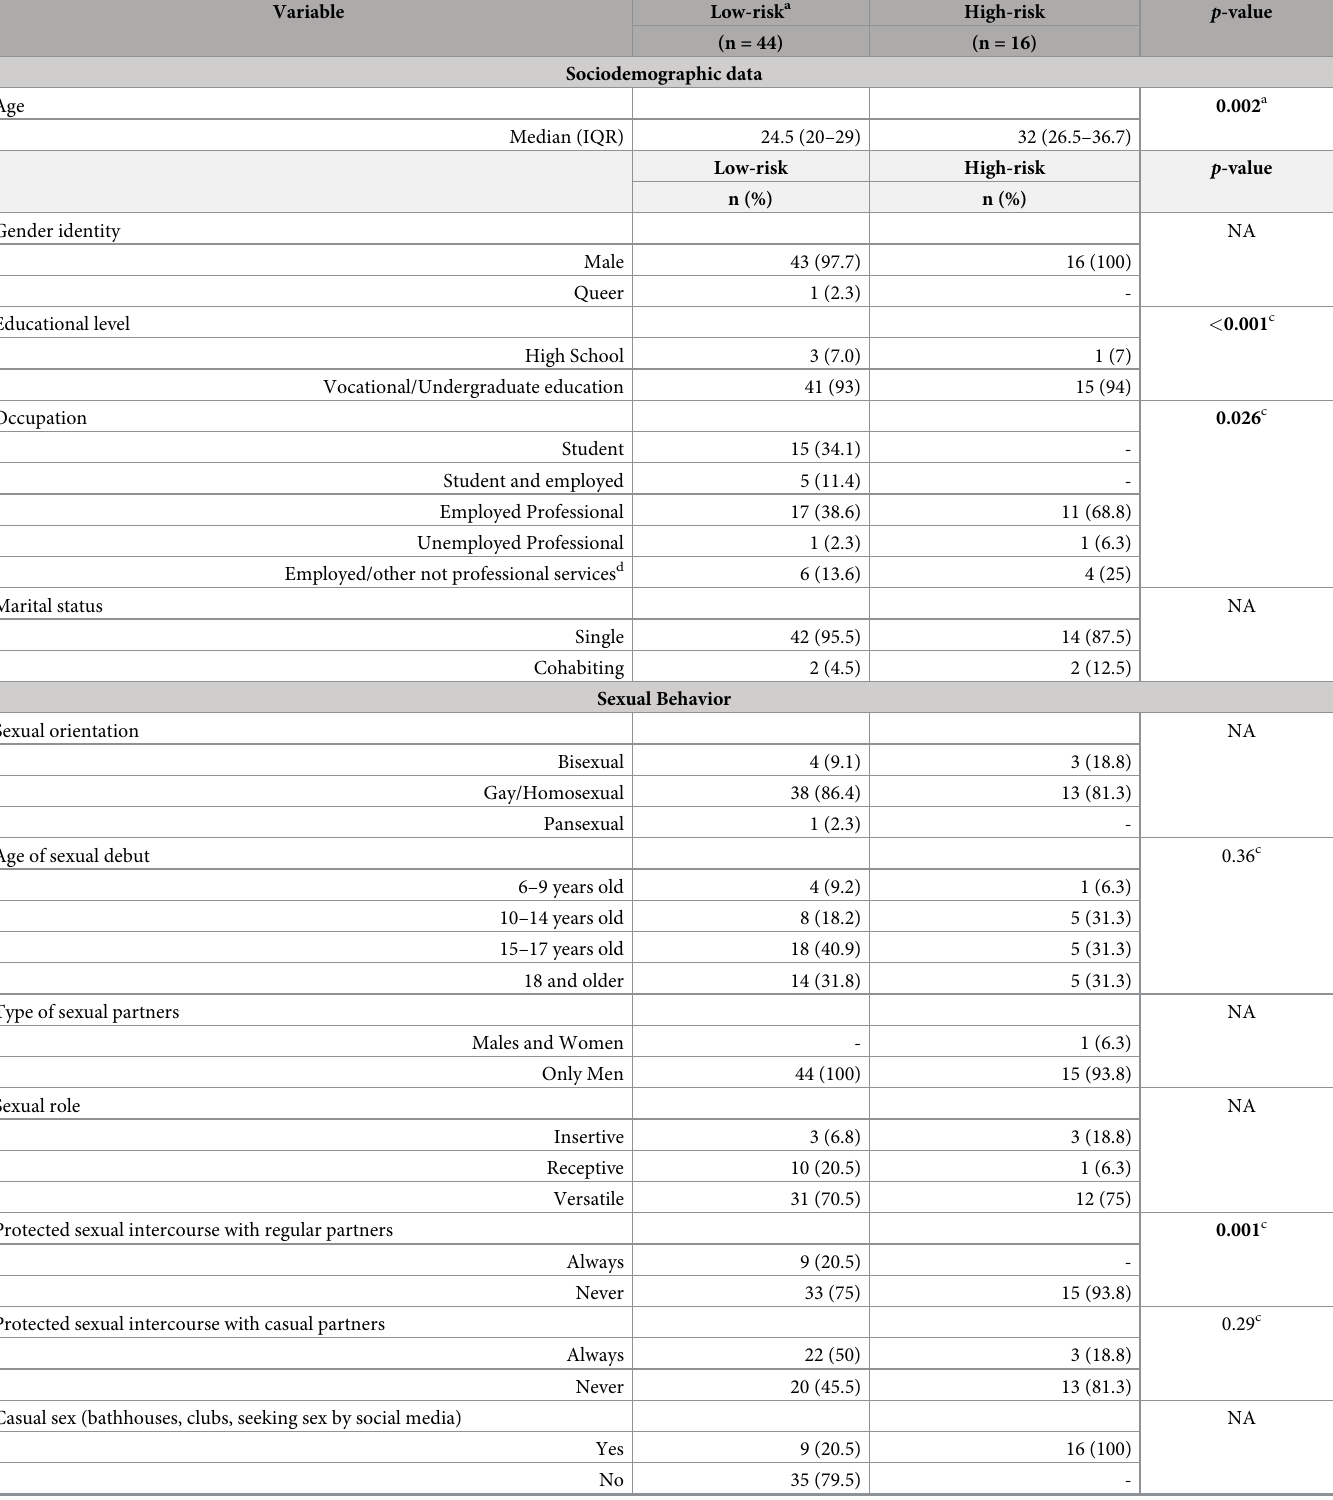
Table 1. Sociodemographic and sexual behavior data of the low- and high-risk groups of